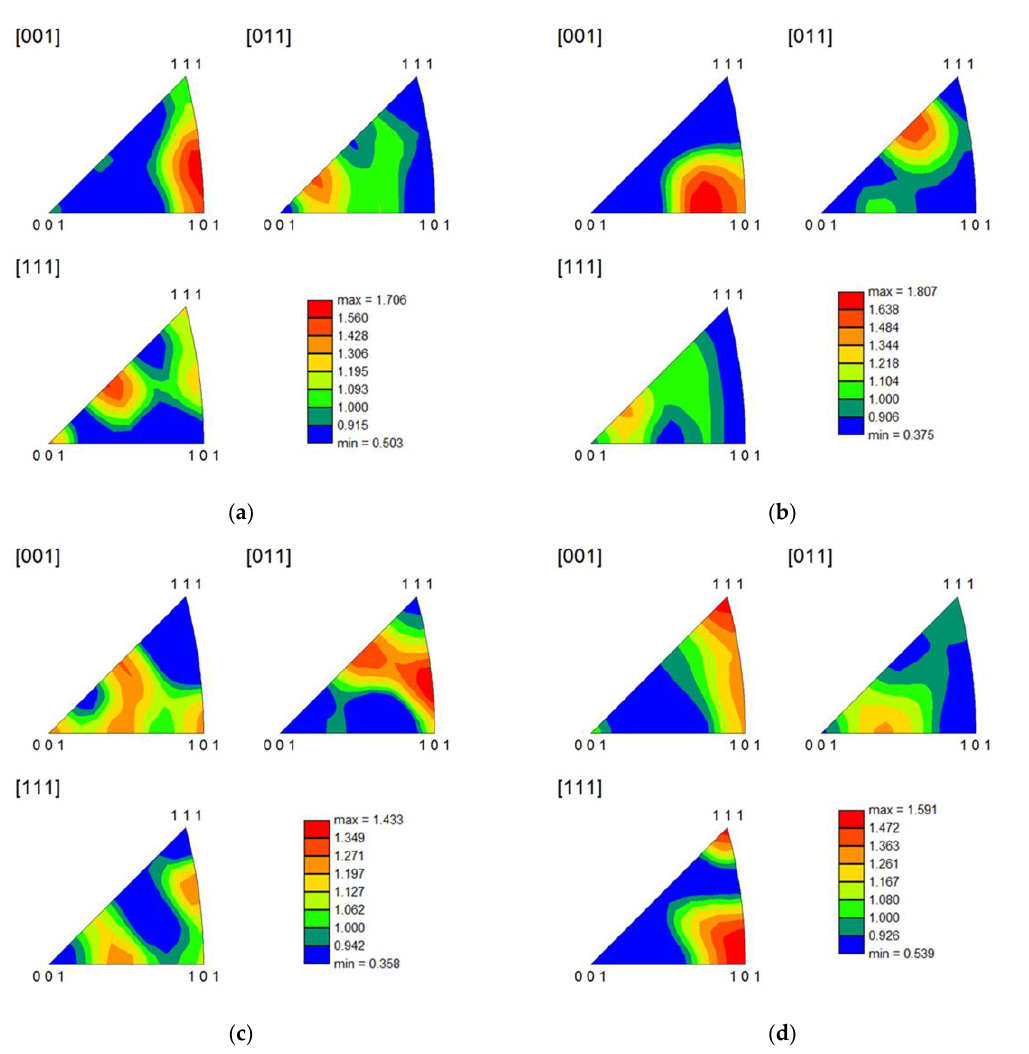
Figure 7. Inverse pole figures of the ( a ) aluminum and ( b ) nickel matrices and ( c ) Al/CNTs and ( d ) Ni/CNTs nanocomposites .